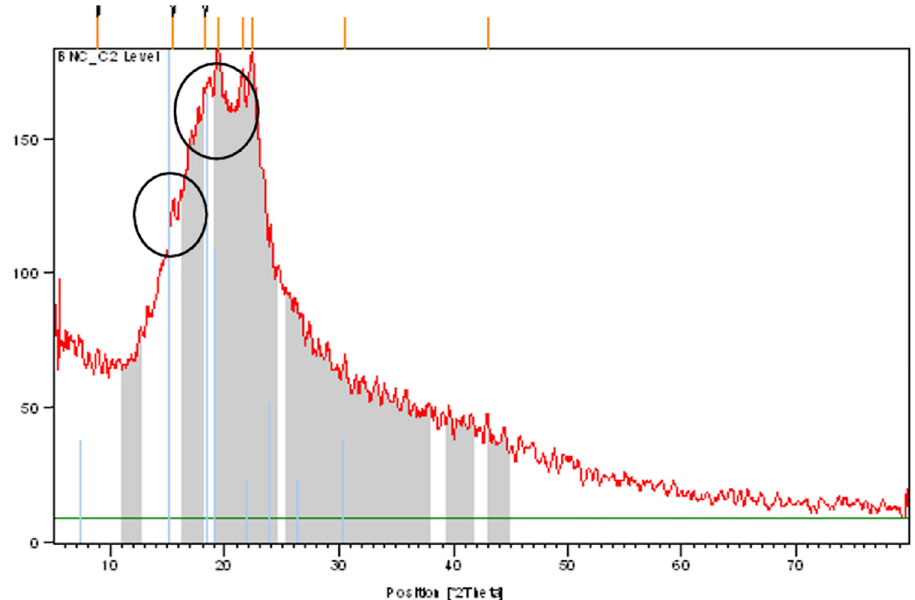
Figure 11: XRD analysis of extracted BNC produced by P. kudriavzevii USM - YBP2. The highlighted areas are the peak intensity with di ff raction angles of crystalline ( 15.5°, 19.4°, and 22.3° ) and amorphous ( 18.3° )